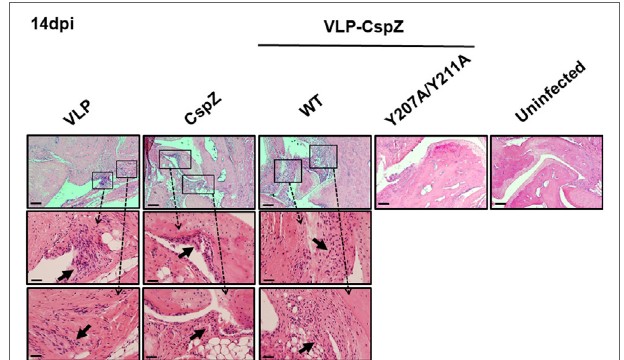
FigUre 5 | VLP-CspZ-Y207A/Y211A immunization prevents Lyme arthritis in Borrelia burgdorferi- infected C3H/HeN mice at levels similar to uninfected mice. Three C3H/HeN mice were vaccinated with virus-like particle (“VLP”), CspZ (“CspZ”), VLP-CspZ (“VLP-CspZ-WT”), or VLP-CspZ-Y207A/Y211A (“VLP-CspZ-Y207A”) and subsequently infected with 10 4 B. burgdorferi strain B31-A3. Tibiotarsus joints were collected 14 days post infection and also from three uninfected mice of the same age. To assess inflammation, tissues were fixed and stained with hematoxylin and eosin. The representative images from one mouse per group are shown here. Top panels are lower-resolution images [joint, 10 × (bar, 160 µm)]; bottom panels are higher-resolution images [joint, 2 × 20 (bar, 80 µm)] of selected areas (insets in top panels). Arrows indicate infiltration of immune cells.